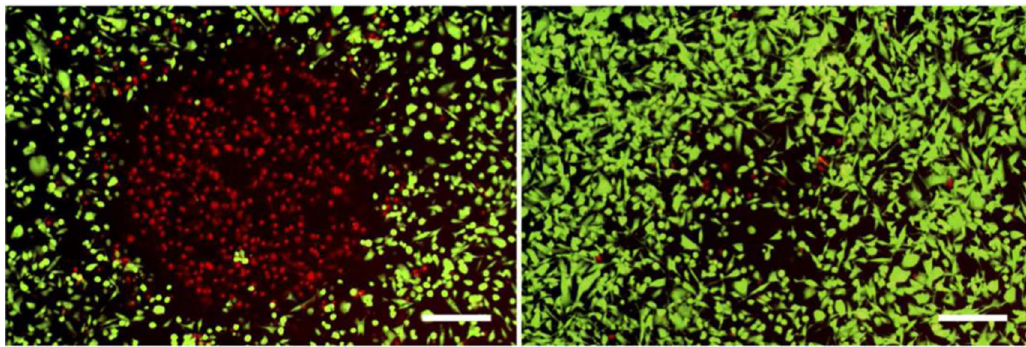
Figure 29: Viability staining of BT-549 breast cancer cells incubated with AuNS-DTDC@SiO2-PpIX-TAT NPs (left) and AuNS-DTDC@SiO2-TAT NPs particle concentration of 0.1 nM (right) after 30 s of light irradiation 4.4 W cm − 2 for 30 s (mercury arc lamp, fi ltered at 633 nm). Live cells are stained green and dead cells are stained red. Scale bars are 250 μ m [67]. With permission from American Chemical Society.